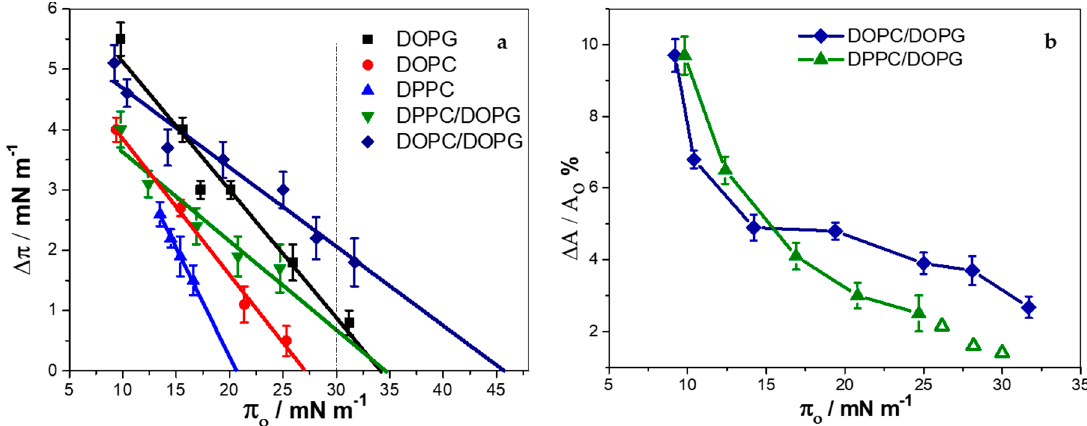
Figure 1. Insertion of KR 9 C into monolayers of the indicated composition (average ± SD of at least three experiments). Changes in surface pressure ( a ), or in mean molecular area ( b ) upon addition of 10 µ M of peptide as a function of the initial surface pressure. The open symbols in panel ( b ) were calculated from data obtained from the linear fit in panel ( a ). π e is the value of π in which ∆ π = 0. ∆π depends on the amount of peptide incorporated, on the rearrangement caused by the peptide on the surrounding lipids, and on the stiffness of the monolayer (i.e., the surface pressure response of the film, due to a change in the area per lipid). In order to better compare the effect of peptide incorporation into DOPC/DOPG and DPPC/DOPG films (which depict different stiffness), we